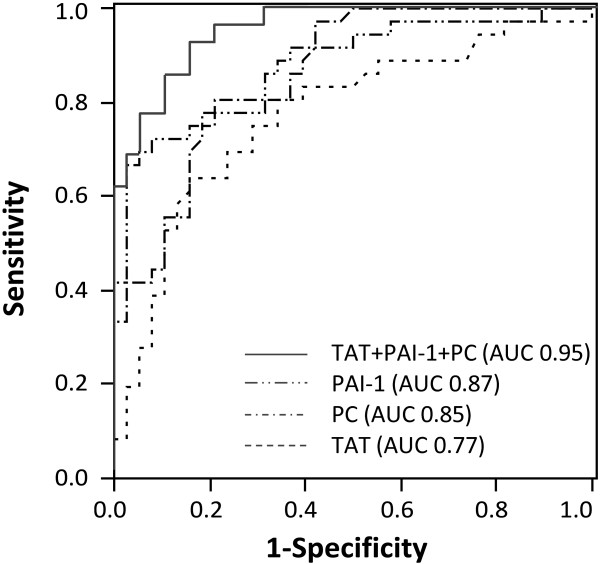
ROC curves of TAT, PAI-1 and PC activity for prediction of overt DIC. Area under the receiver operating characteristic curve (AUROC) for thrombin-antithrombin complex (TAT), 0.77 (95% CI, 0.64 to 0.86), plasminogen activator inhibitor-1 (PAI-1), 0.87 (0.78 to 0.92), protein C (PC), 0.85 (0.76 to 0.91), and combination of these biomarkers are described. Combination of TAT, PAI-1 and PC was superior to each marker alone (AUROC, 0.95 (vs. TAT, P = 0.0004; vs. PAI-1, P = 0.033; vs. PC, P = 0.025)).